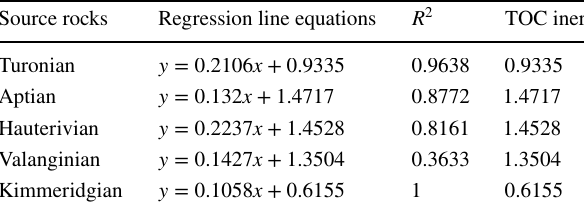
Source rocks Regression line